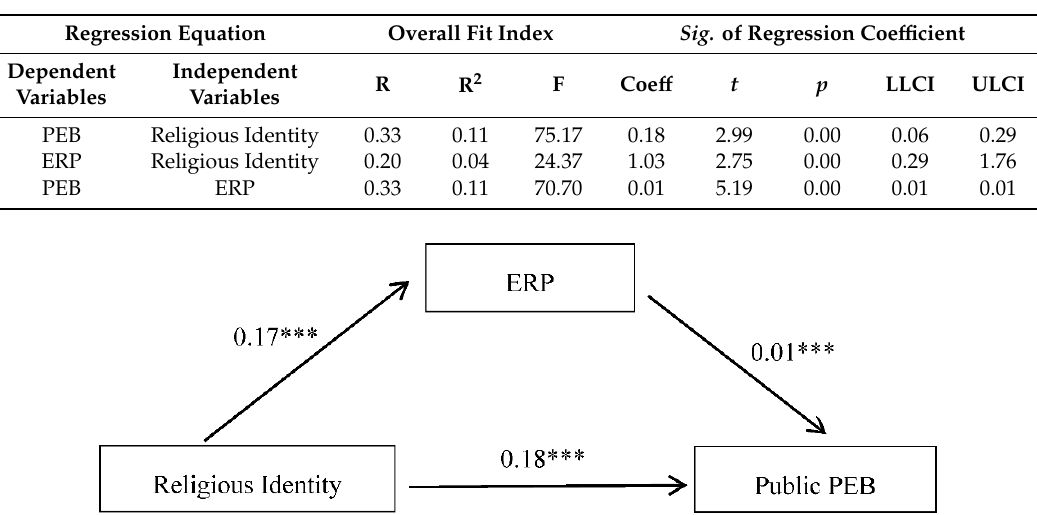
Table 3. Regression analysis of variables in the model.